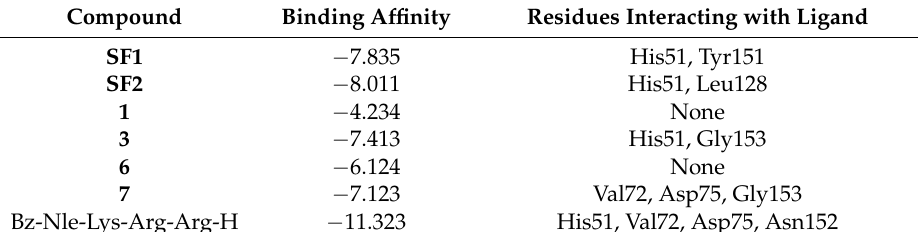
Table 3. DENV2 NS2B/NS3 protease binding affinity (kcal/mol) and ligand interactions.